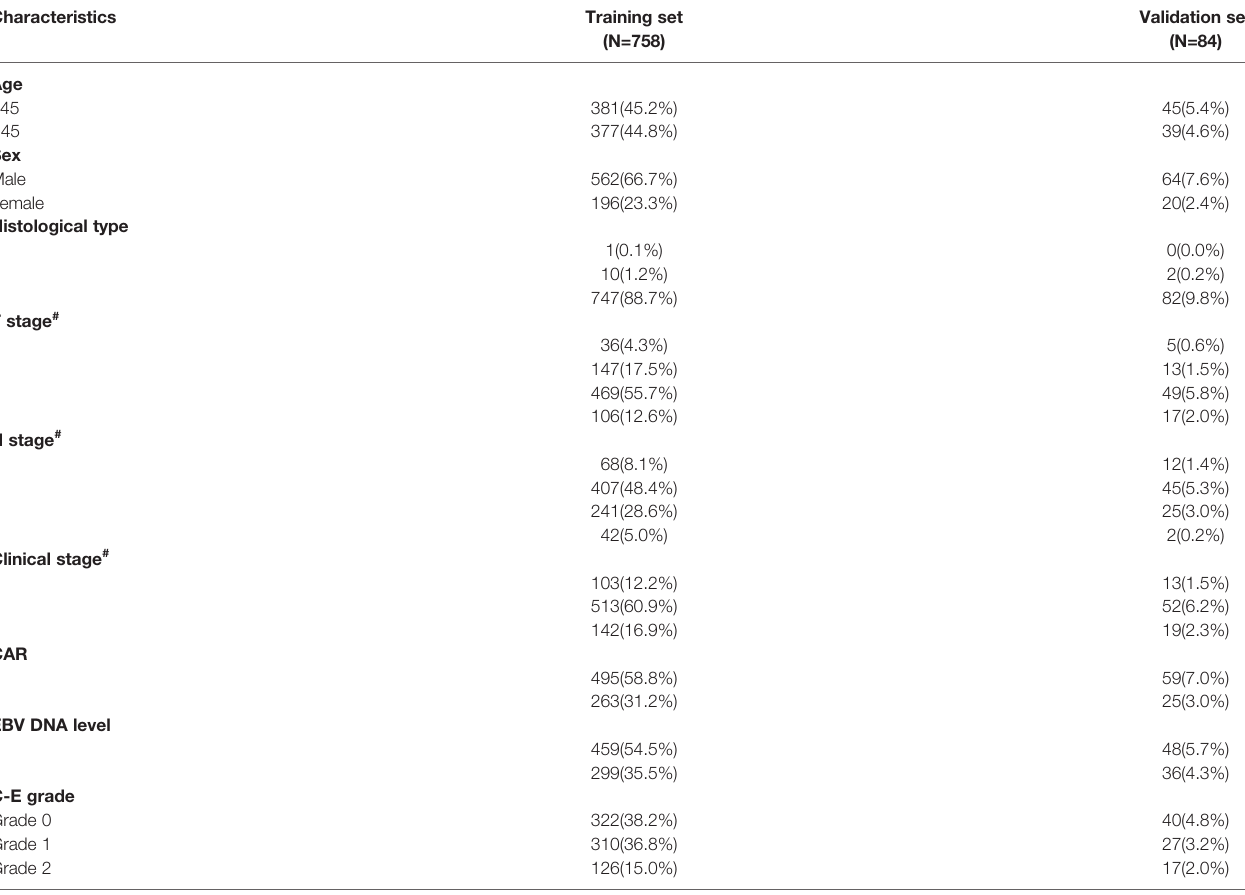
TABLE 2 | Clinicopathologic characteristics of the patients.